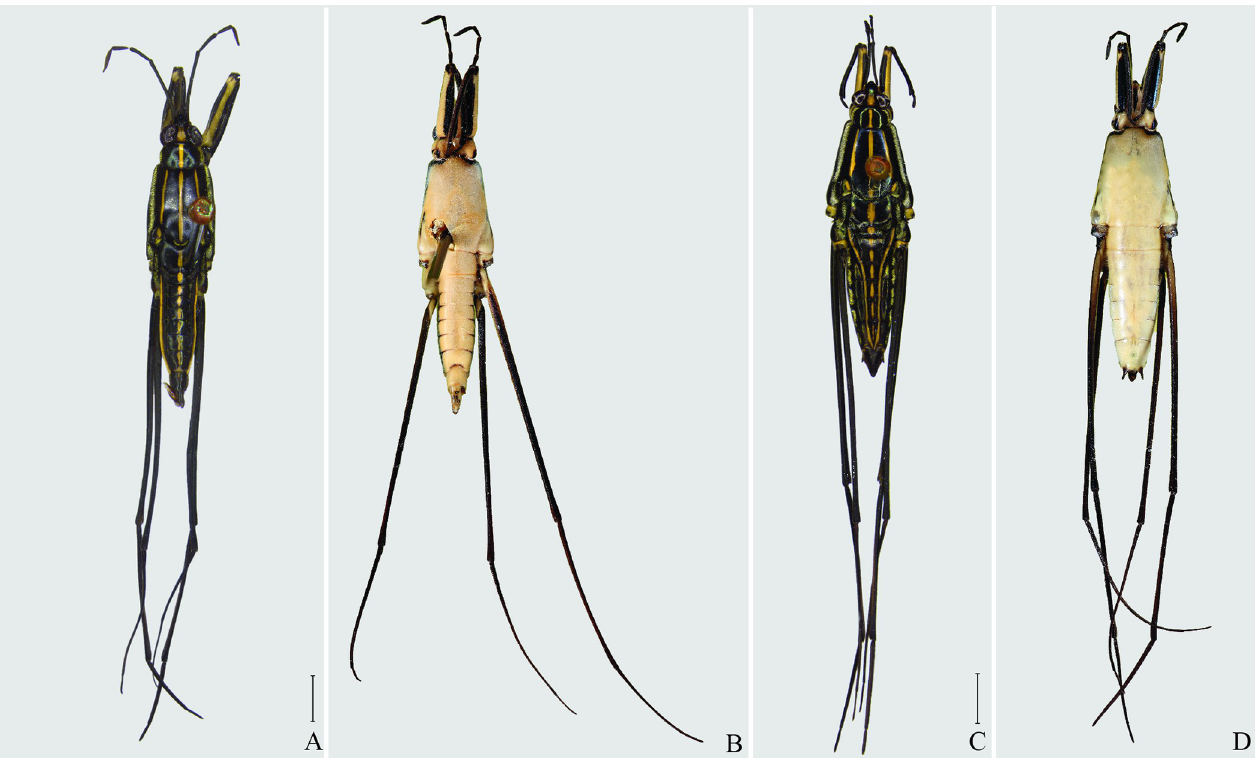
Fig 4. Brailovskybates thomasi new comb. (A) Male, dorsal view; (B) male, ventral view; (C) female, dorsal view; (D) female, ventral view.